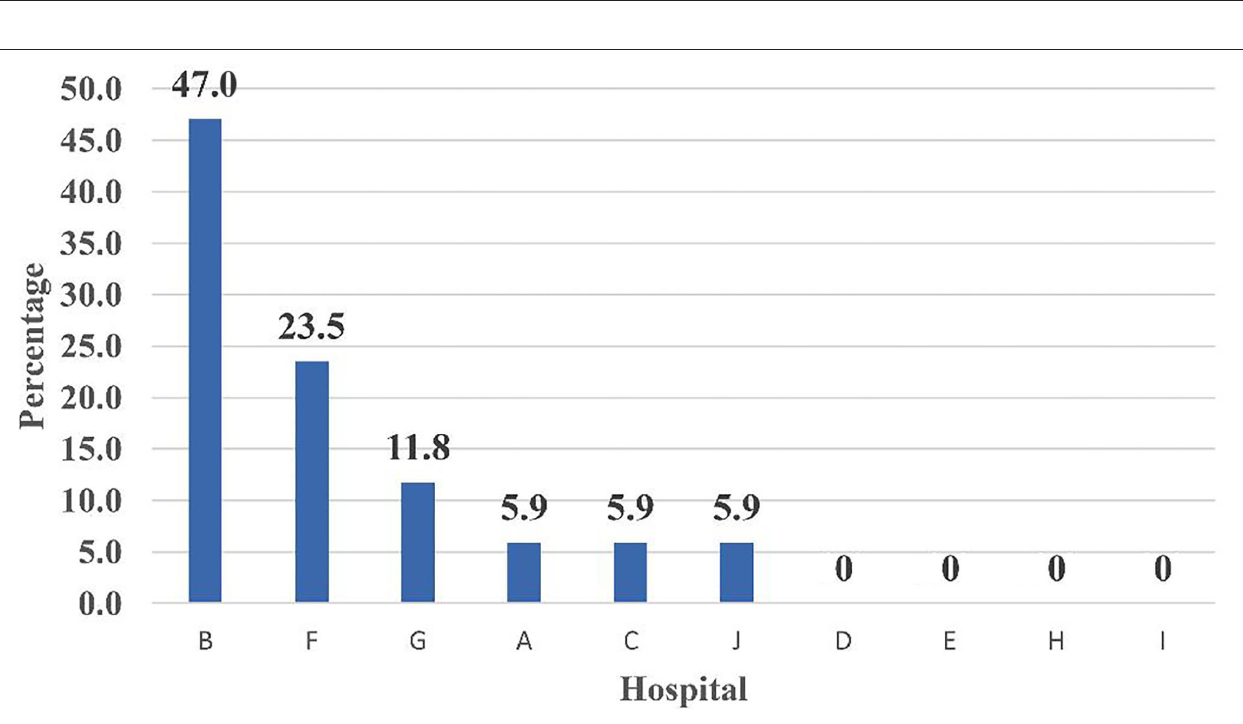
FIGURE 6 | Percent distribution of PCR confirmed COVID-19 across 10 Teaching hospitals among medical cases who utilized ICU—Egypt: (June 1 to July 15, 2020)—Rank ordering.